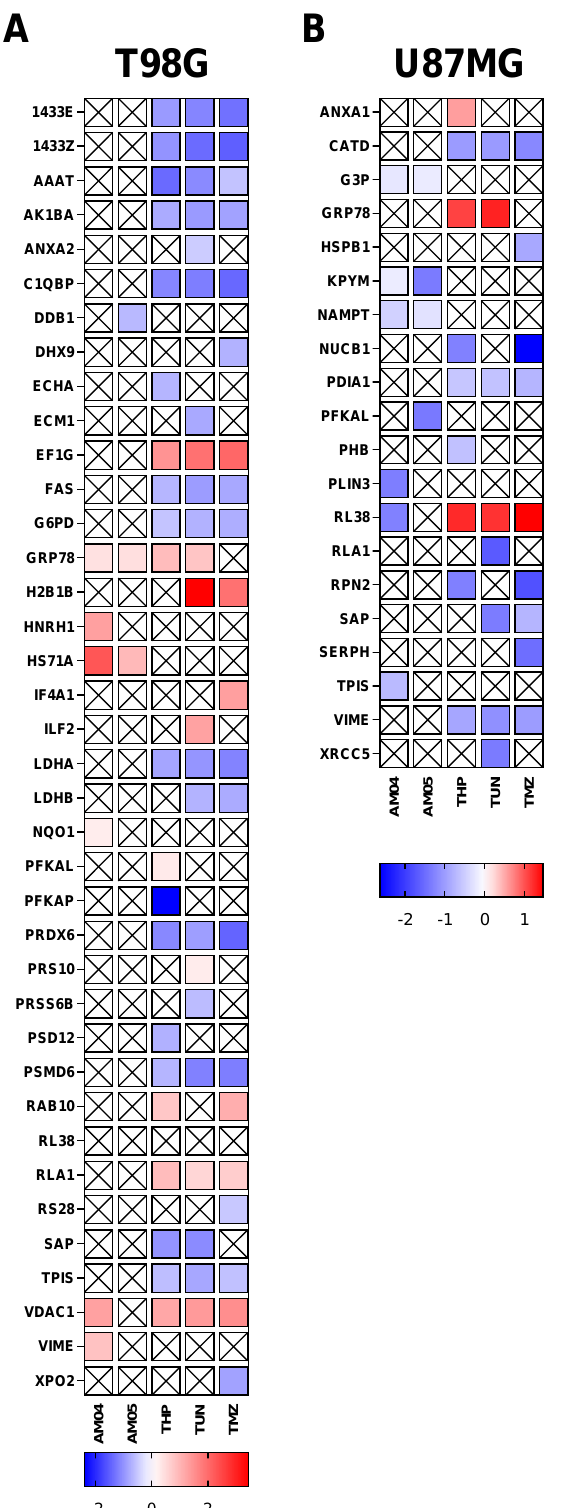
Figure 7. Quantitative proteomic analysis of T98G ( A ) and U87MG ( B ) under effect of several compounds obtained by shotgun bottom up proteomics after iTRAQ labelling. Protein are expressed as log2 fold change for statistically significant ( p < 0.05, t-test).